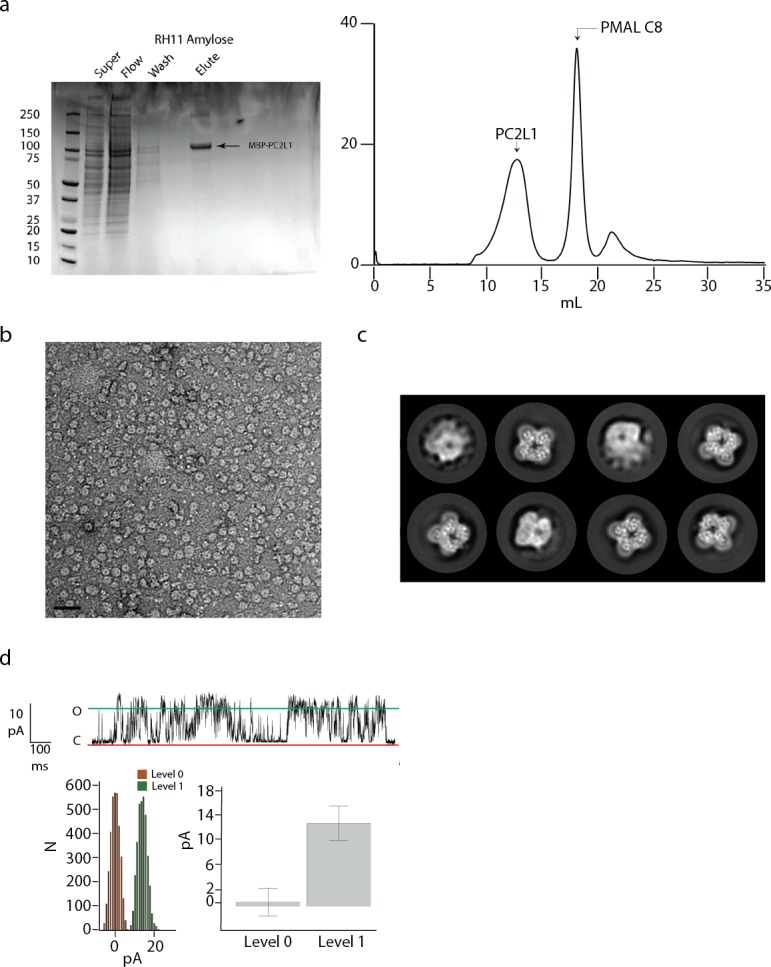
Purification, negative staining, 2D class average and function of polycystin 2-l1.(a) SDS-PAGE of amylose purification for supernatant, flow, wash and elution (left). Size exclusion chromatography (Superose 6 Increase) after affinity chromatography and exchange from detergent to amphipol PMAL-C8 (right). (b) Representative sample of negative-stained polycystin 2-l1 in PMALC8 (scale bar, 200 nm). (c) 8 representative 2D class averages used in data processing. (d) Sample trace of voltage-clamped, liposome-reconstituted recombinant polycystin 2-l1 (top). Amplitude histogram of open and closed events (bottom left) and mean current of open (Level 1) and closed (Level 0) events. Average current = 13.2 pA (±2.8 S.D.) at +125 mV, 1.6 s duration.